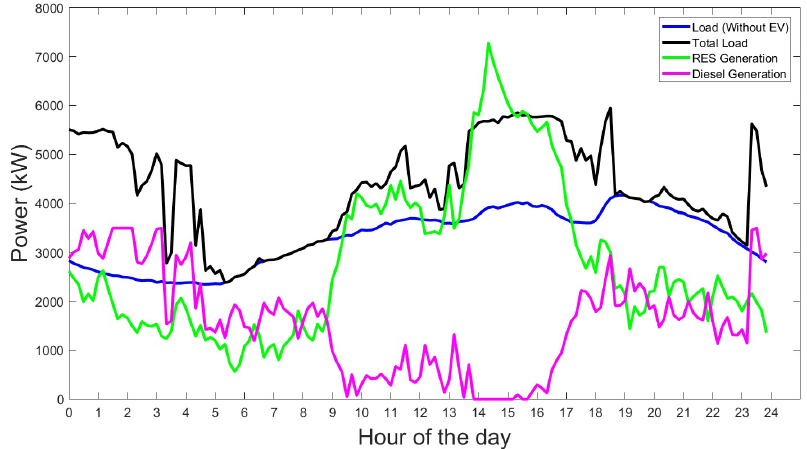
Figure 5. Loads and Generation Profiles, with smart charging, for Scenario 1.